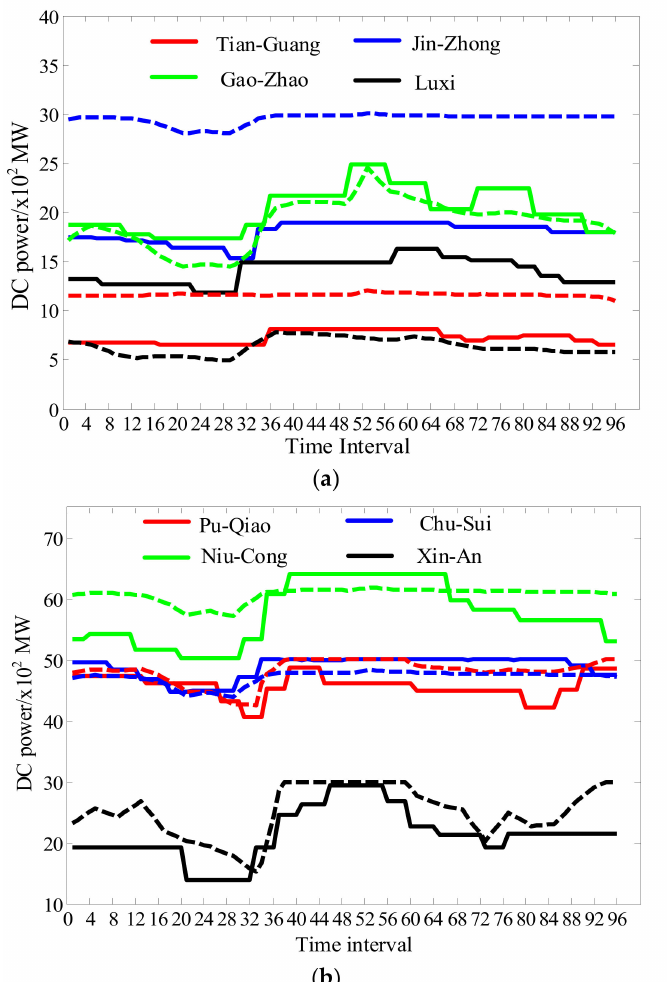
Figure 5. Comparison of the DC channel power before and after optimization (the dashed line represents the result before optimization, and the solid line represents the result of optimization). ( a ) Four DC channels; ( b ) Other four DC